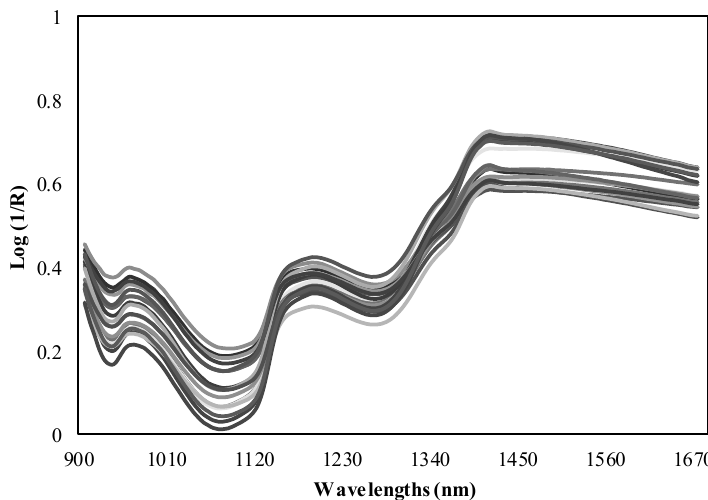
Figure 1. NIR spectra measured by the MicroNIR spectrometer.